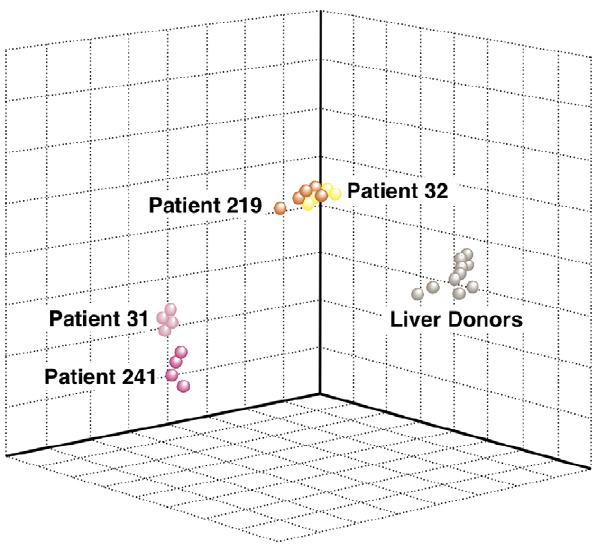
Figure 3. Multidimensional scaling. Three-dimensional (3D) pro- jection of 17 liver specimens from 4 patients with ALF and 10 specimens from individual liver donors by multidimensional scaling using all 11,597 transcripts that passed the filtering criteria. In the 3D projection, each point represents an individual liver specimen, and the distance between points is proportional to the overall dissimilarity of gene expression profiling. The plot illustrates how the gene expression profiles differentiate between ALF and liver donors, as well as among ALF patients. ALF patients with massive hepatic necrosis (MHN) (Patients 241 and 31) and those with submassive hepatic necrosis (SHN) (Patients 219 and 32) form two distinct clusters whose distance from liver donors reflects the extent of liver injury.